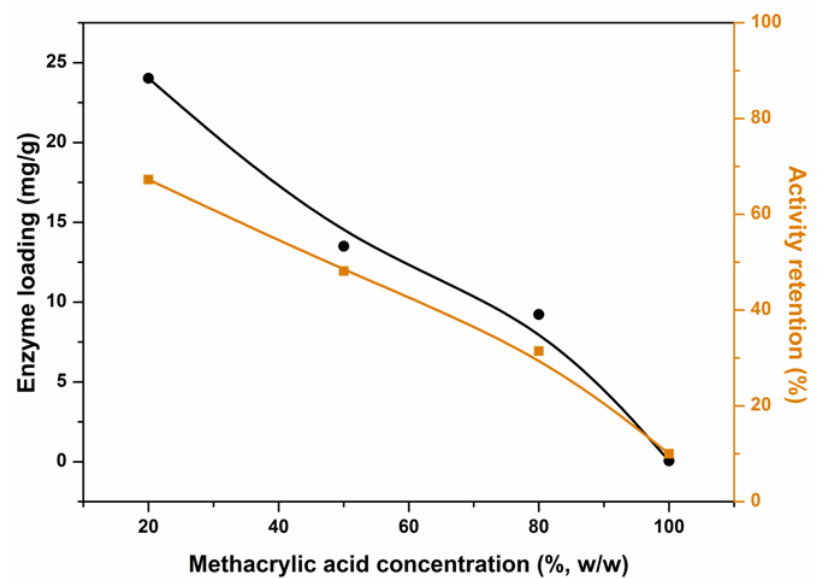
Figure 8. Effect of methacrylic acid concentration on lipase loading ( • ) and activity ( 